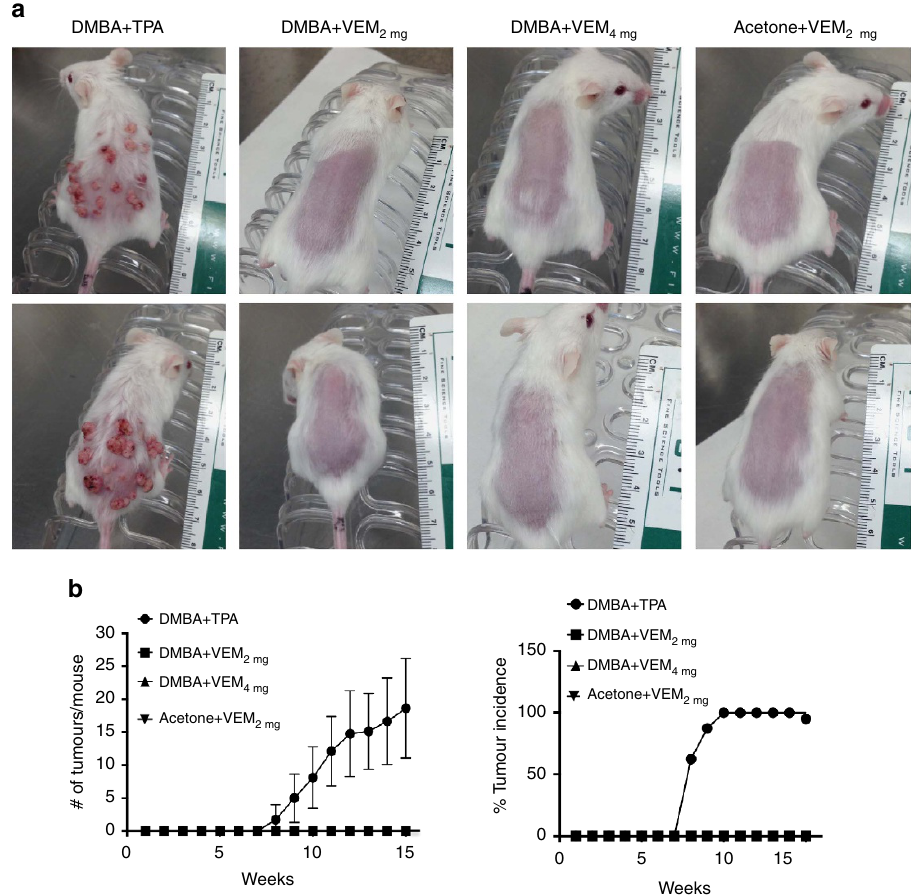
Figure 7 | Vemurafenib does not induce skin tumours when applied topically to mice. ( a ) Representative images of mice from each study group on week 15 of treatment. Topical application of 7,12-Dimethylbenz[a]anthracene (DMBA) to FvB/N mice followed by 12-O-tetradecanoylphorbol-13-acetate (TPA) induced skin papillomas and squamous cell carcinomas by week 8 of treatment. In the control (DMBA þ TPA) group all eight mice developed tumours. In the groups with DMBA or acetone control, followed by topical application of vemurafenib (VEM, 2 or 4mg per mice) no skin tumours were induced. ( b ) Graph representations of tumour count and percentage of tumour incidence per week. Error bars in b , mean ± s.d.; n ¼ 2-mm-wide strip contained a horizontal wound sample 20 . The strips were spread on filter papers soaked in ice-cold PBS in covered Petri dishes until WTS measurement, as previously described 21 using an Instron tensiometer (Model 3342; Instron, Norwood, MA, USA). The skin strips were stretched at a rate of 1cmmin (cid:2) 1 to breaking point to obtain the peak WTS in gf per 2mm. The WTS of unwounded skin from 12 weeks old mice is 250 gf (ref. 20). Excisional skin wound splinting model . Seven- to nine-week old female Balb/c mice were used for these studies under the ACR protocol #2010-011-13F. Mice were anaesthetized with 2–3% isoflurane in an induction chamber and kept under anaesthesia during the whole surgery. The back of the mice was shaved, washed with betadine and 70% ethanol and a dose of buprenorphine (2.5mgkg (cid:2) 1 ) was administered, subcutaneously, before the surgery. Two excisional wounds were made in the skin aside the midline of the animal using a 6-mm biopsy punch. Twenty microliter of vemurafenib (0.1mg m l (cid:2) 1 ) or DMSO was applied topically on the wounds 1min before suturing of the splinting rings. The splinting rings have an 8-mm transparent window, which was covered with Tegaderm to allow visualization and measurement of the wound size. All animals were observed daily for signs of inflammation and pain for the first 48h post surgery. Vemurafenib or DMSO was repeatedly applied on day 2 and 4. Wounds were photographed at day 0, day 2, day 6 and day 14, based on which the percentages of wound closure were calculated. Histological analyses . Dorsal skin wounds from CH3 mice treated with vemurafenib suspension or DMSO in saline-control suspension were excised at day Balb/c mice were sacrificed at day 2, 6 and 14 with isoflurane overdose. Two 8-mm round pieces of tissue were collected from each Balbc/c mouse containing the